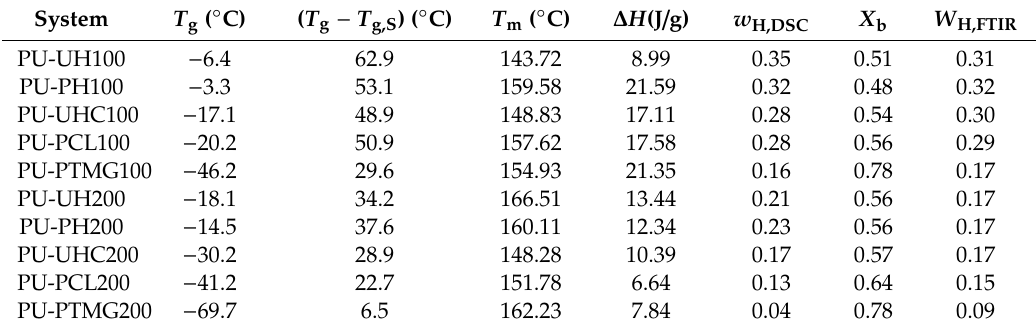
Figure 1. Di ff erential scanning calorimetry (DSC) curves for the di ff erent polyurethanes (PUs) studied showing the transitions characteristics of first (continuous line) and second scans (dashed line). ( a ) system with macrodiol of 1000 g / mol molar mass and ( b ) system with macrodiol of 2000 g / mol. UH, poly(hexamethylene) carbonate diol; PH, poly(hexamethylene–pentamethylene) carbonate diol; UHC, poly(hexamethylene–caprolactone) carbonate diol; PCL, polycaprolactone polyester diol; PTMG, Table 2. Values of the glass transition temperature ( T g ); temperature di ff erence ( T g – T g,S ); melting temperature ( T m ); melting enthalpy ( ∆ H ); fraction of rigid segment in the soft phase, w H,DSC ; fraction of hydrogen-bonded urethane carbonyl groups in the rigid segment region, X b ; and maximum rigid segment–flexible segment mixing determined by FTIR analysis, w H,FTIR . DSC, di ff erential scanning calorimetry; FTIR, Fourier transform